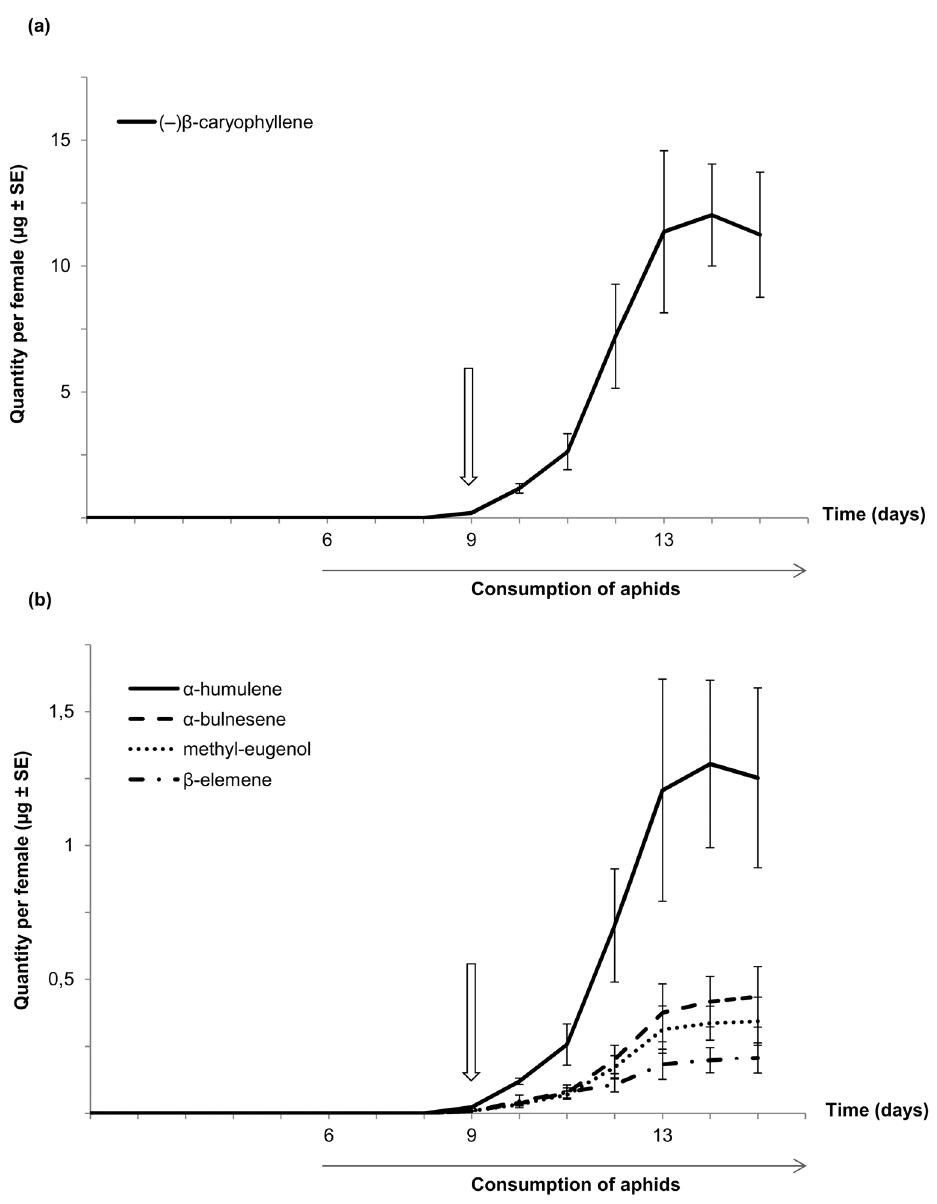
Fig. 2. Emission profile of the sex pheromone. The quantities ( m g) per virgin female are expressed as (–)- b - caryophyllene equivalent on a daily basis (mean ¡ SE of three replicates). Panel (a) corresponds to (–)- b - caryophyllene which is depicted separately from the other four compounds because of the large difference in terms of quantities (see ordinate axes). Panel (b) represents the emission profile of b -elemene, methyl- eugenol, a -humulene, and a -bulnesene at a different scale. Downward pointing arrows indicate the onset of calling behavior which coincides with pheromone emission on the ninth day.